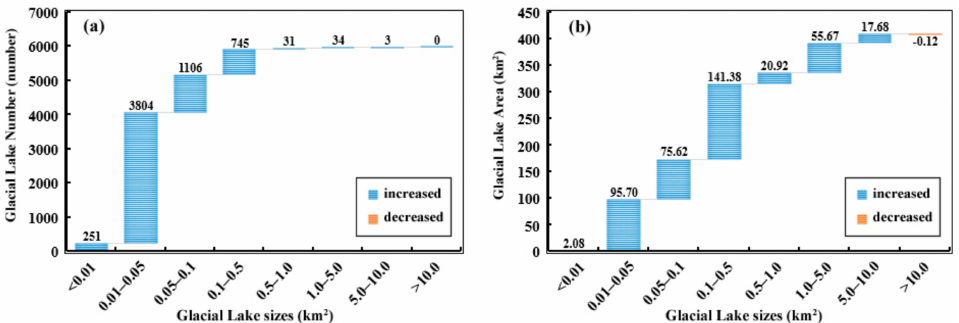
Figure 9. Changes in the number and area of glacial lakes of different sizes in the HKH-TMHA region from 1990 to 2020. ( a ) number, ( b )